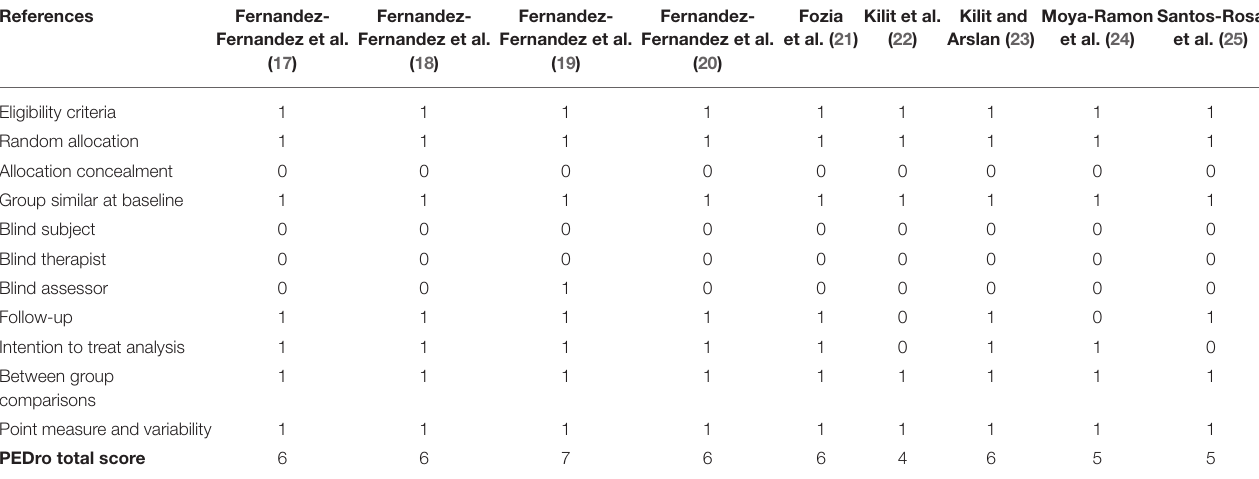
TABLE 3 | Methodological quality